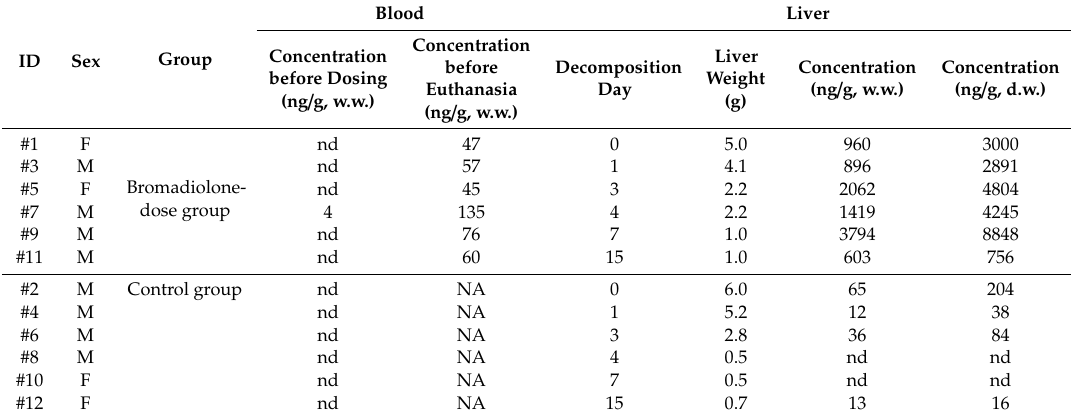
Table 2. Bromadiolone concentration in blood (before dosing and euthanasia) and liver (according to the days of decomposition) of common kestrels in the bromadiolone-dose and control